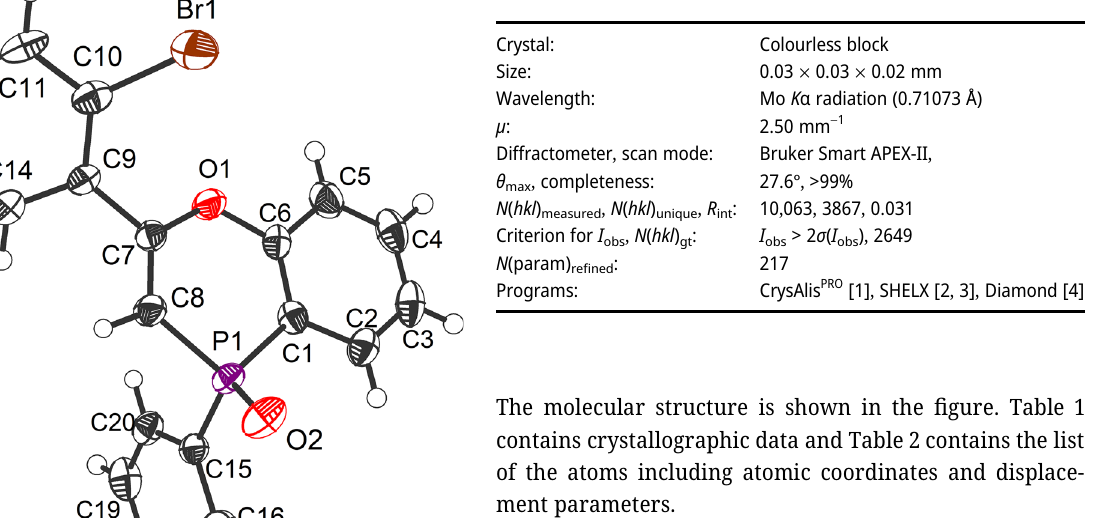
Table  : Data collection and